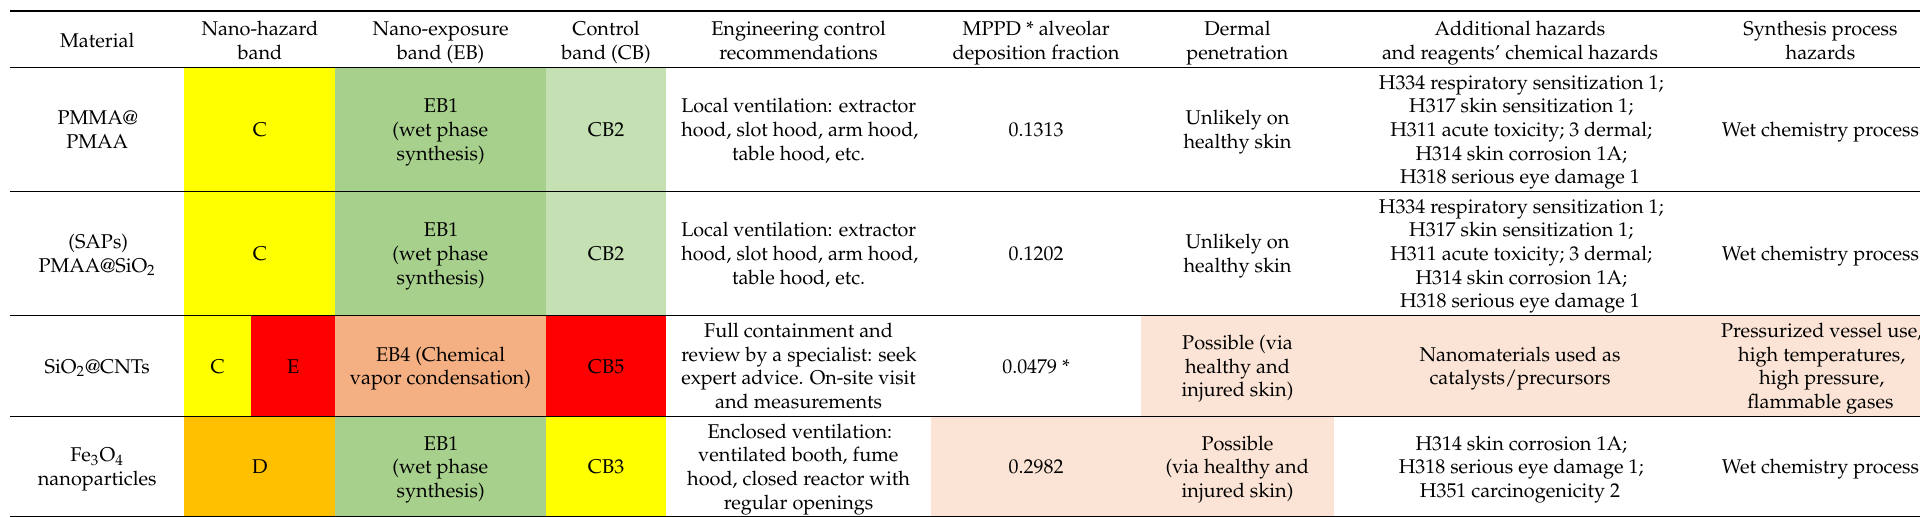
Table 2. Summary of the control banding results and additional assessment